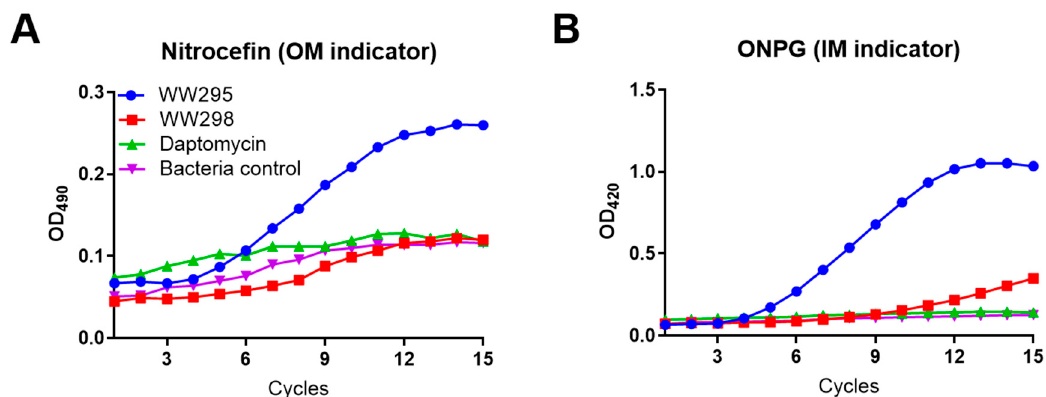
Figure 4. Simultaneous permeation of the outer and inner membranes in the E. coli ML35p reporter strain by peptide WW295 and WW298. The detection of nitrocefin at 490 nm as a product of beta-lactamase cleavage is a reporter for the outer membrane ( A ) and cleavage of ONPG by the cytoplasmic β -galactosidase into o-nitrophenol, monitored at 420 nm is the evidence for the inner membrane permeation ( B ). Plots shown here are at 3.1 µM of peptide concentration plotted as a function of relative fluorescence units with time. Each cycle is of 5 min. Bacteria cells without any treatment were used as controls.